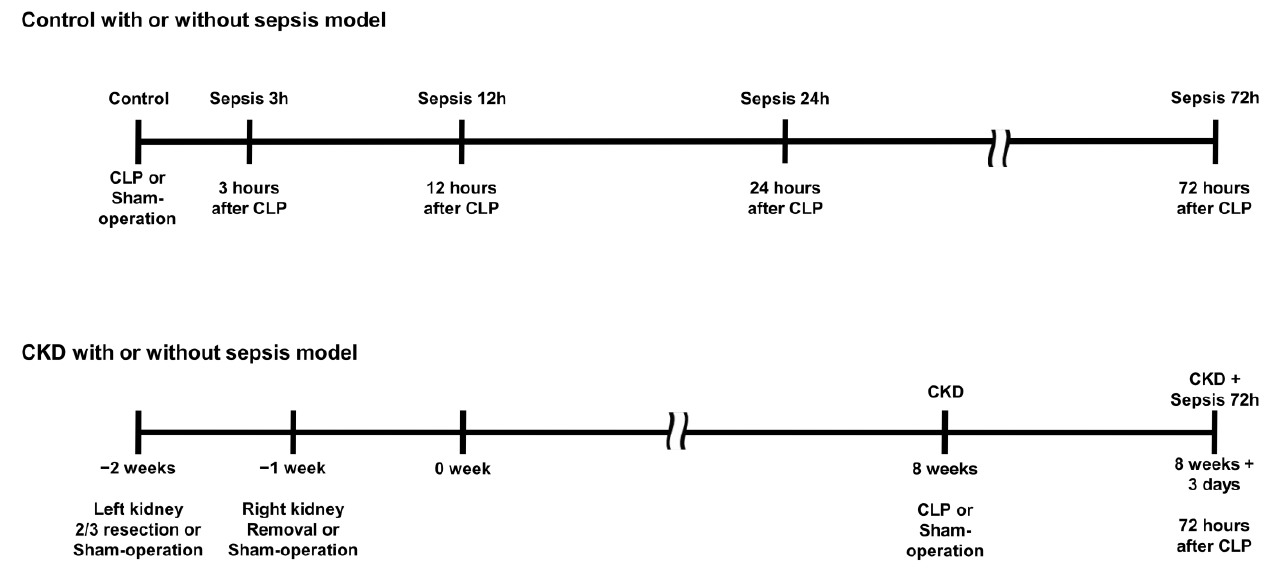
Figure 4. Experimental design. In the control group (sham - operated model), blood and urine col- lection and lung harvest were performed before cecal ligation and puncture (CLP) and after 3 h, 12 h, 24 h, and 72 h of CLP. In the chronic kidney disease group (CKD, 5/6 nephrectomized), CLP or sham operation was performed after 8 weeks of 5/6 nephrectomy. Blood and urine collection and lung harvest were performed before CLP and after 72 h of CLP. lung harvest were performed before CLP and after 72 h of